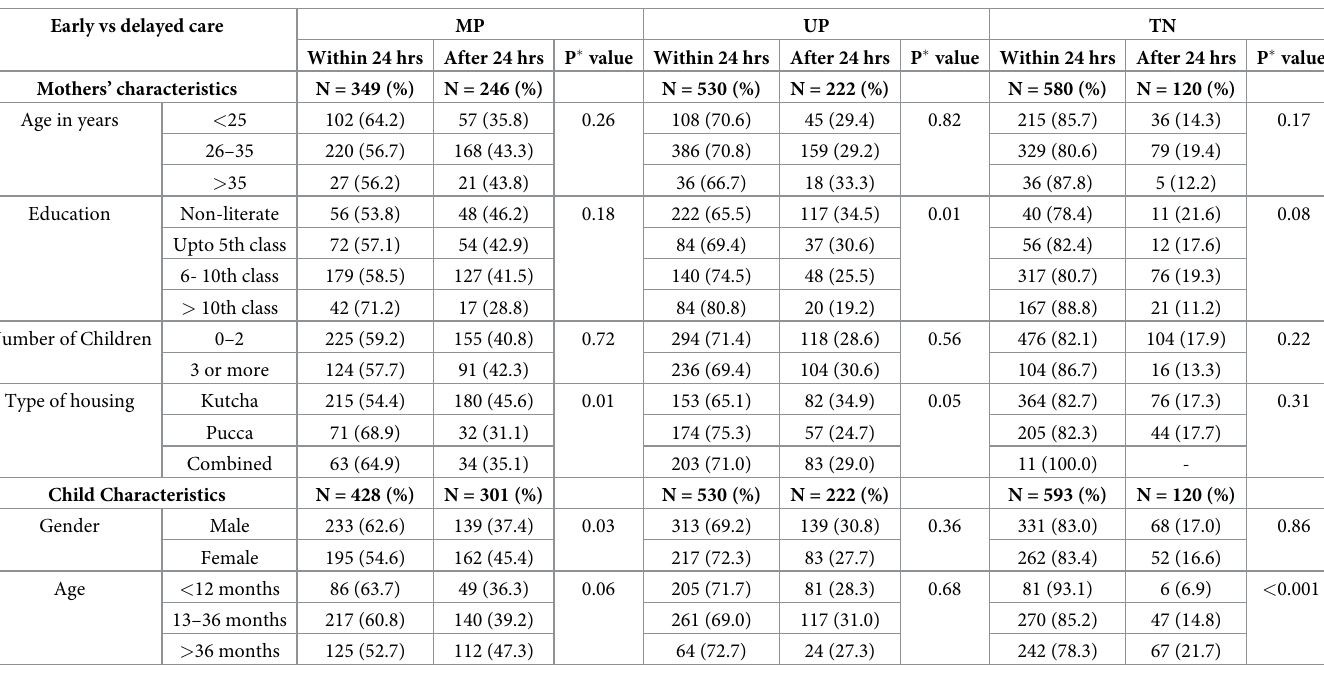
Table 7. Association of socio-demographic characteristics to early care sought. Early vs delayed